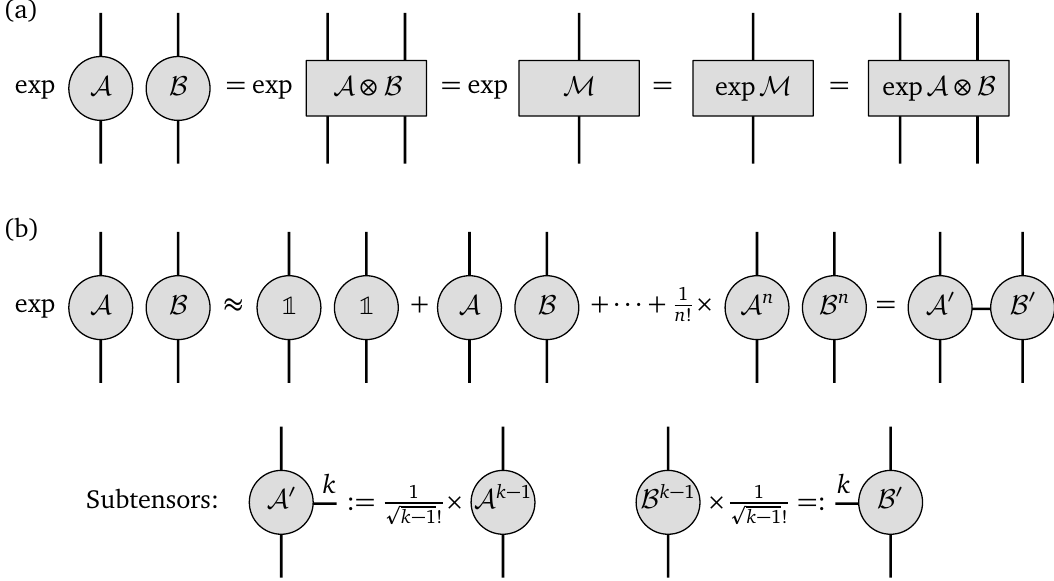
Figure 11: Two strategies for exponentiating a Kronecker product of two tensors A ⊗ B (i.e. hosting the matrix elements of two local operations on a lattice). Both demonstrate the power of combining several basic tensor operations with a unified graphical notation. (a) The exact exponential exp { A ⊗ B } is formed from first expanding the Kronecker product to a full four-link tensor (by contracting over an inserted dummy link, cf. Fig. 8 (a)). Fused into a square matrix M , this tensor can be exponentiated with matrix numerical routines. Finally, we split the fused links into the original configuration. (b) The Taylor-series expansion up to (small) order n can be rewritten as a contraction of smaller tensors A (cid:48) and B (cid:48) over a third, shared link k of dimension = n + 1. To this end, scaled powers of A , B are inscribed as subtensors into A (cid:48) , B (cid:48) d k at the respective index values of k , as depicted. Note that in practice, conditions on numerical stability